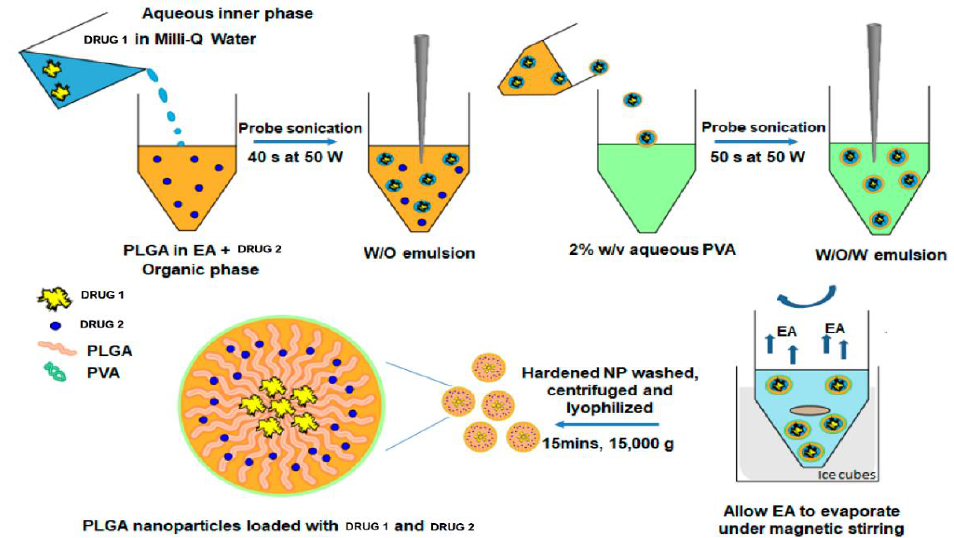
Figure 2. Example of a formulation method for the preparation of poly(lactic acid-co-glycolic acid) (PLGA) nanoparticles (NPs). Diagram shows preparation of PLGA NPs for the simultaneous delivery of two different drugs. The drug-loaded NPs are prepared by a double emulsion-solvent evaporation method. Abbreviations: PVA—polyvinyl alcohol; EA—ethyl acetate. Adapted and modified with permission from [31].